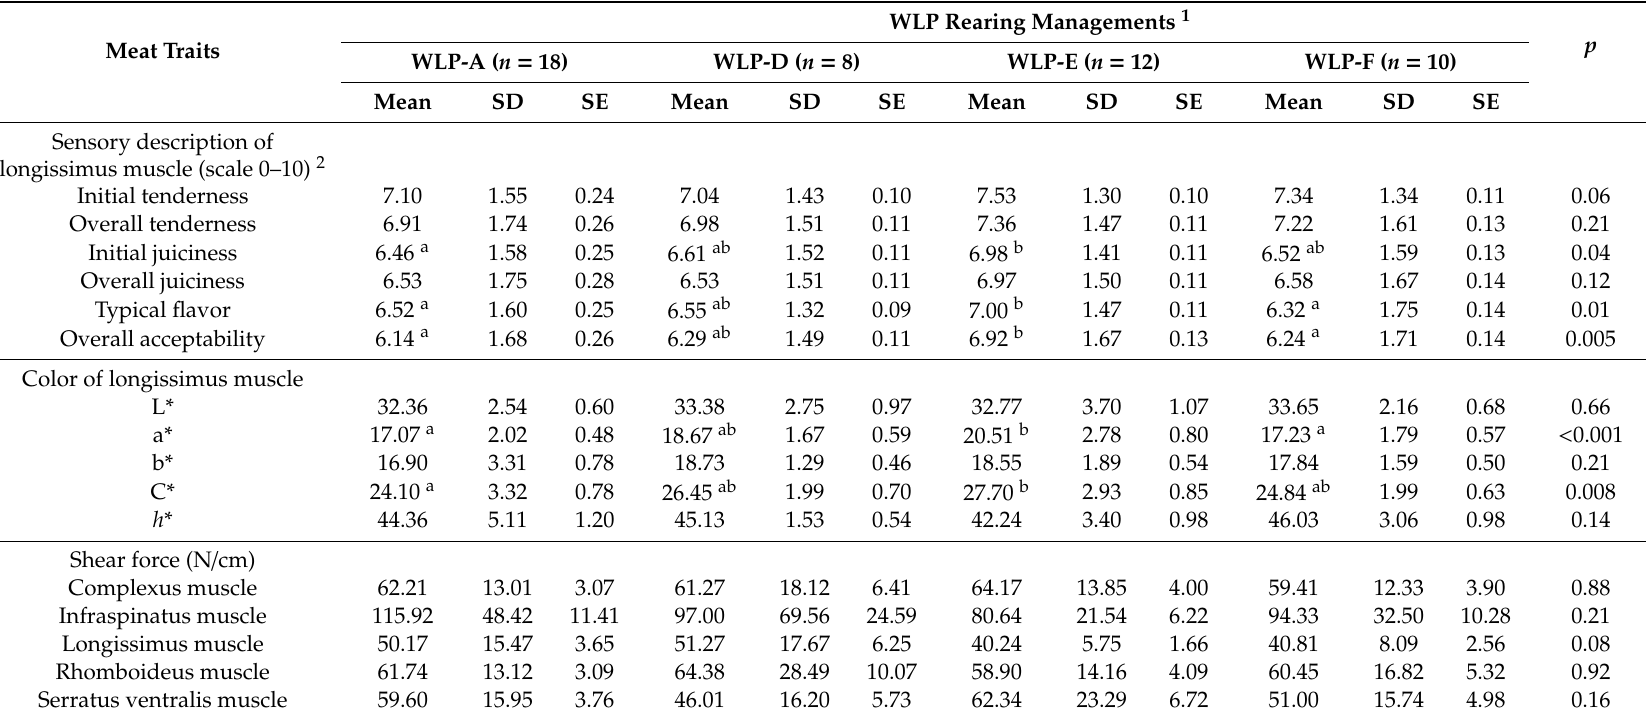
Table 2. Impact of the four rearing managements applied during the heifers’ whole life period (WLP) on the traits of five rib muscles.